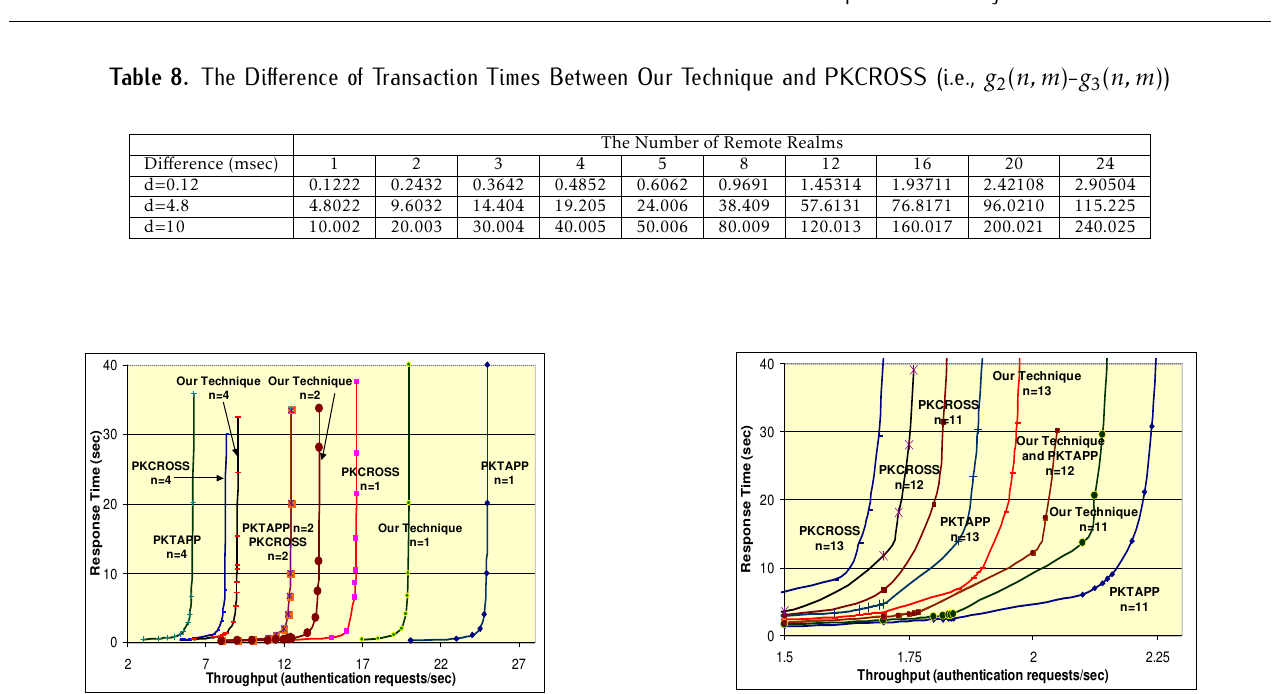
Figure 13. Response Times vs. Authentication Request Rates